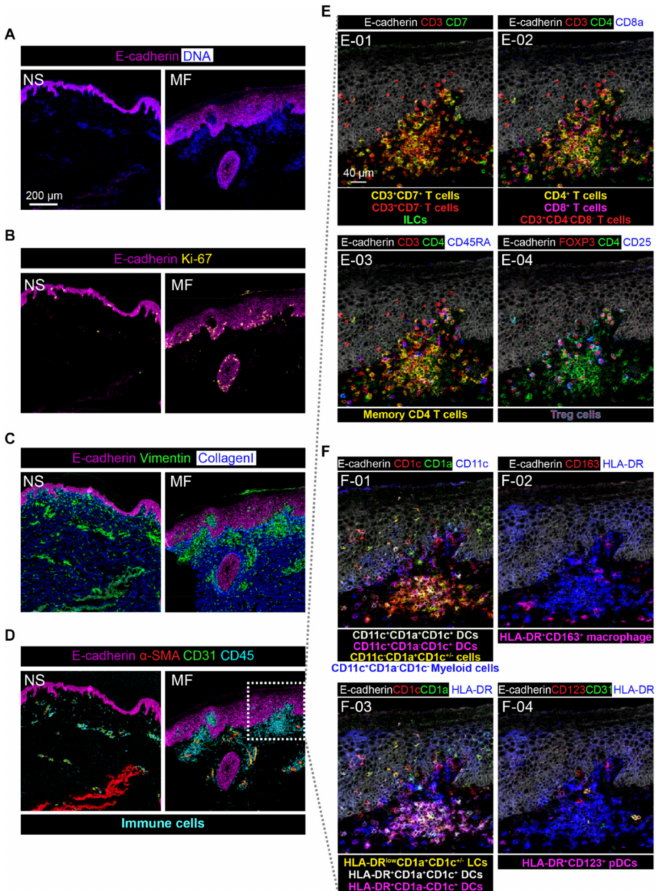
Figure 5. Visualization of the structure and the spatial distribution of the immune and stromal cell subsets in a single ROI in skin tissue by imaging mass cytometry: ( A – D ) representative mass cytometry images of an NS and an MF skin sample showing the overlay of ( A ) E-cadherin (colored in magenta) and DNA (colored in blue); ( B ) E-cadherin (colored in magenta) and Ki-67 (colored in yellow) to identify proliferating keratinocytes (E-cadherin + Ki-67 + ); ( C ) E-cadherin (colored in magenta), vimentin (colored in green), and collagen I (colored in blue) to distinguish the epidermis and dermis; ( D ) E-cadherin (colored in magenta), α -SMA (colored in red), CD31 (colored in green), and CD45 (colored in cyan) to show the location of CD45 +/dim immune cells; ( E ) identification of T-cell and ILCs subsets for the MF sample: ( E-01 ) CD3 + CD7 + T cells, CD3 + CD7 − T cells, and ILCs (CD3 − CD7 + ); ( E-02 ) CD4 + T cells (CD3 + CD4 + ), CD8 + T cells (CD3 + CD8 + ), and CD4 − CD8 − T cells (CD3 + CD4 − CD8 - ); ( E-03 ) memory CD4 + T cells (CD3 + CD4 + CD45RA − ); ( E-04 ) regulatory T cells (Tregs, CD3 + CD4 + CD25 + FOXP3 + ). ( F ) Identification of myeloid cell, dendritic cells, and macrophage subsets from the MF sample: ( F-01 ) different dendritic cell subsets based on different expression levels of CD11c, CD1a, and CD1c; ( F-02 ) CD163 + macrophage (HLA-DR + CD163 + ); ( F-03 ) epidermal Langerhans cells (LCs, HLA-DR dim CD1a + CD1c + ) and dendritic cells (DCs); ( F-04 ) plasmacytoid dendritic cell-like cells (pDC-like, HLA-DR + CD123 +